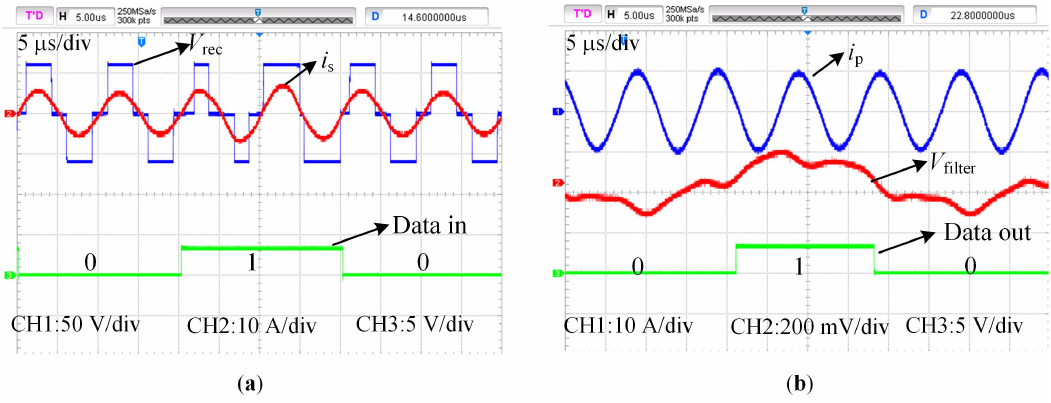
Figure 17. Experimental results of backward communication. ( a ) Measured waveforms of V rec and i s when the transmitted bits are “010” (Data in) under ϕ s = 80 ◦ . ( b ) Measured waveforms of i p , V filter and received data (Data